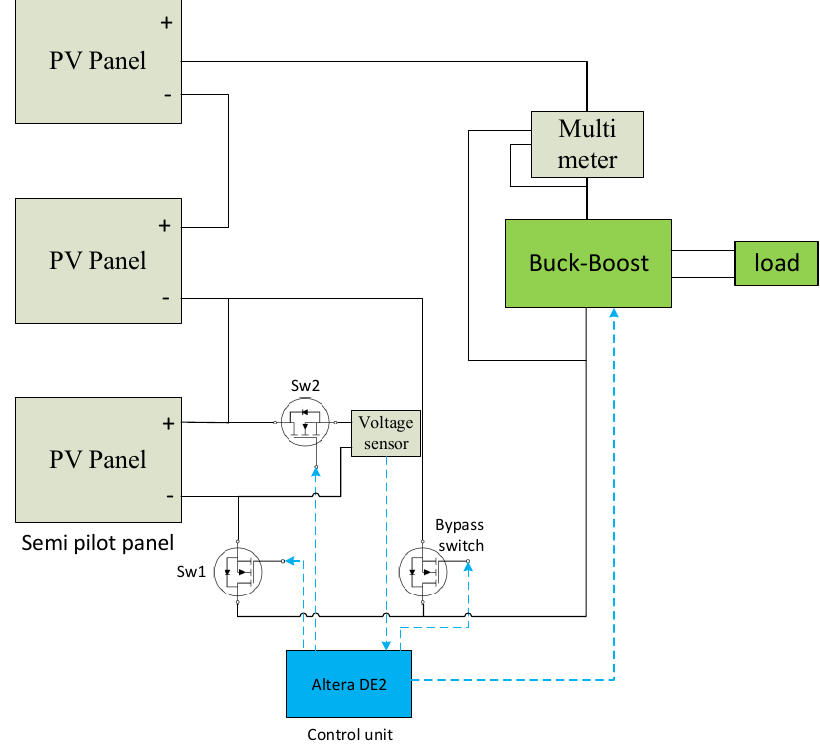
Figure 17. The principle scheme of the experimental